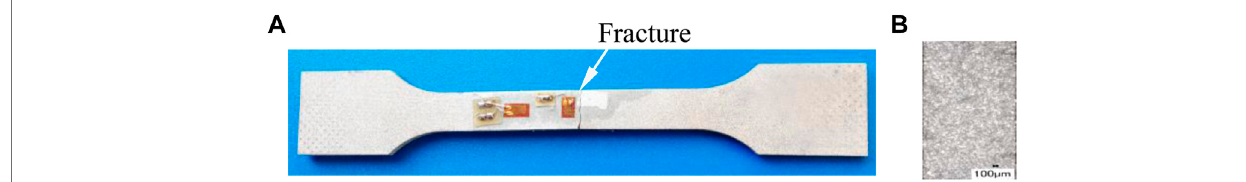
FIGURE 11 | Fracture of specimen after rupture (A) photo of specimen (B) fracture surface.